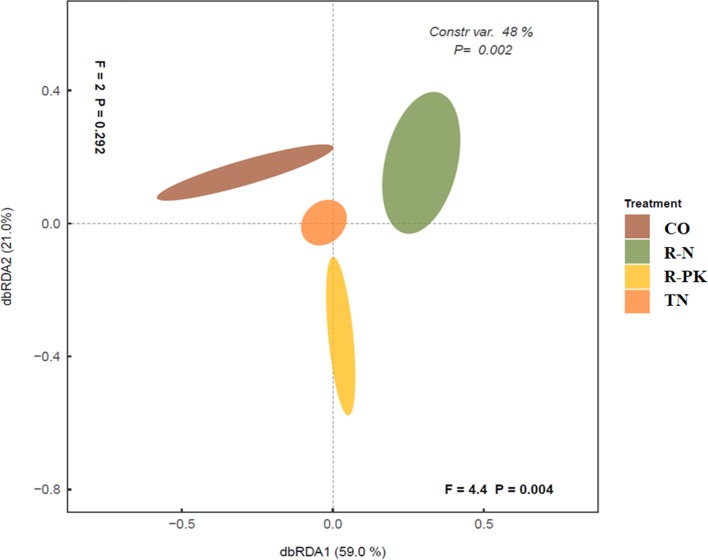
Overall differences among rhizosphere hydrolytic enzyme activities determined by distance-based redundancy analysis (dbRDA) ordination among treatments (TN, TripleN; R-N, Rhizosum N; R-PK, Rhizosum PK) and noninoculated controls (CO). Percentages along the axes show the proportions of dissimilarity captured.